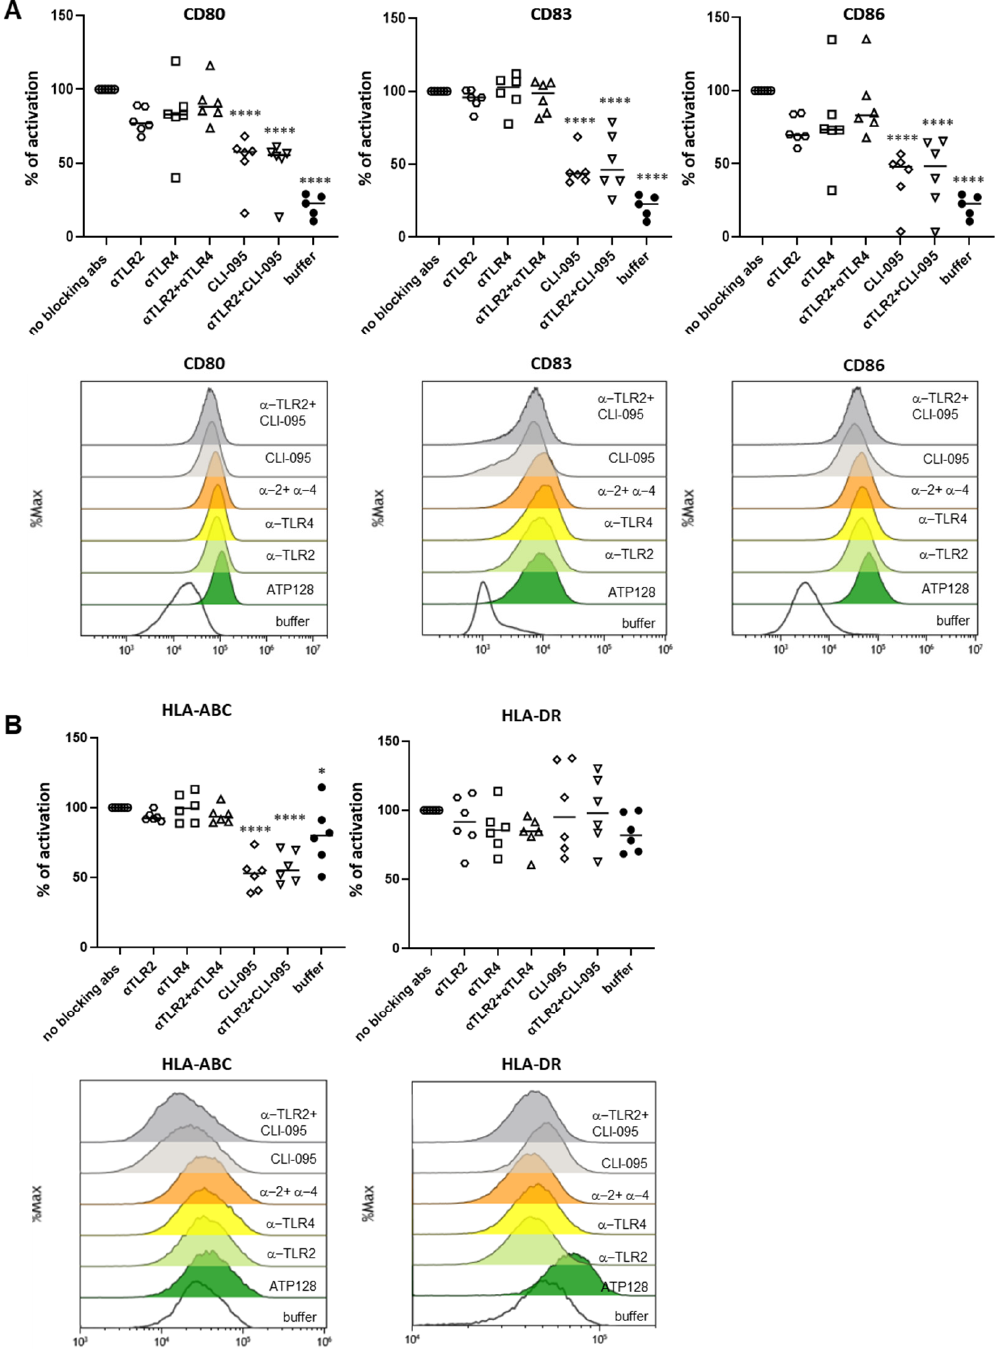
Figure 4. ATP128 engages mostly TLR4 for human moDC activation in an ex vivo system. ( A , B ) Human moDC were pre-treated with anti-TLR2, anti-TLR4 or CLI-095 for 1 h, then stimulated for 24 h with 300 nM ATP128. Cells were collected after stimulation, and surface costimulatory molecules ( A ) and HLA class I and II molecules ( B ) were analyzed through flow cytometry. Each shape is representative of a different buffy coat. Histograms of one representative buffy coat are shown below. Values were compared via one-way ANOVA test to the sample stimulated with ATP128 FL. **** p -value < 0.0001, * p -value < 0.05.